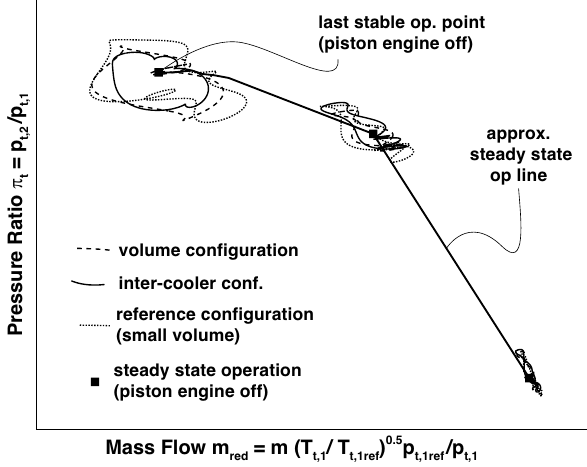
Figure 10. Unsteady compressor performance for exit volume